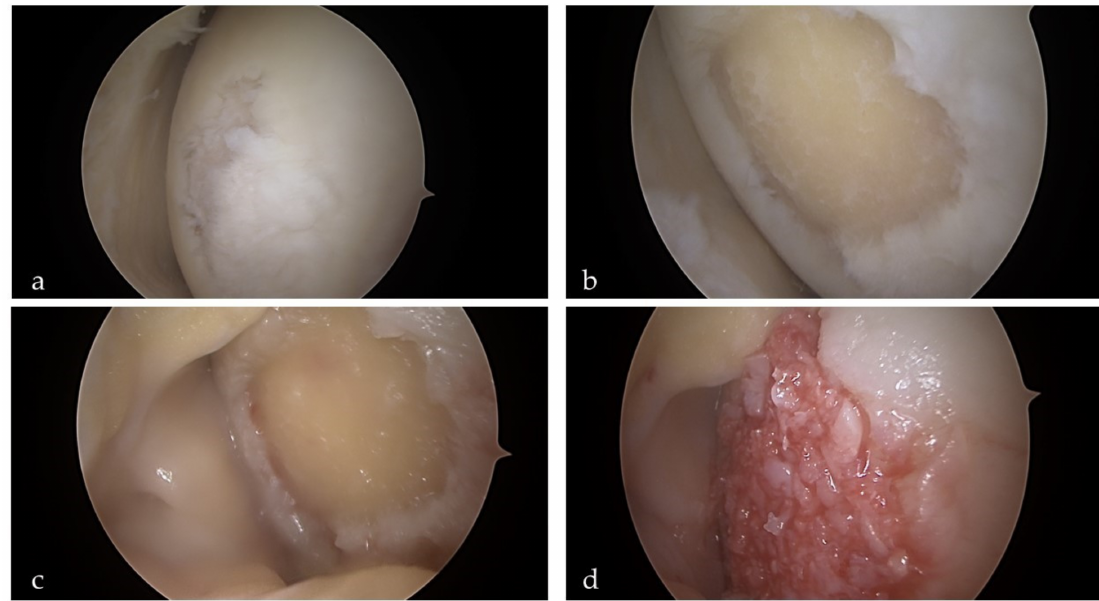
Figure 3. The single-step, full-arthroscopic autologous minced cartilage procedure for the treatment of knee cartilage defect. ( a ) Articular cartilage defect on the medial condyle of the left knee. ( b ) Defect after the debridement of all unstable cartilage with appropriate steep edges. During this step, chondral fragments are harvested for the preparation of the paste. ( c ) The arthroscopic fluid is drained from the knee, and the lesion is dried with a cotton swab. ( d ) Paste mixture containing autologous chondral fragments and platelet-rich plasma (PRP) is carefully placed into the defect. The last step involves the introduction of autologous thrombin serum. The combination of the fibrinogen contained in the paste and the thrombin applied creates a stable clot that holds the mixture in the